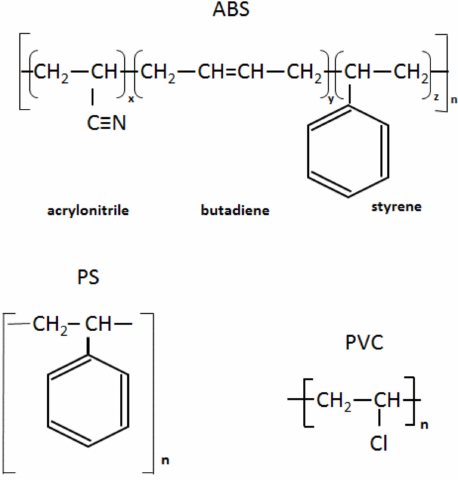
Figure 1. Infrared spectra of recycled acrylonitrile-butadiene-styrene (rABS), recycled polystyrene (rPS) and recycled polyvinylchloride (rPVC).